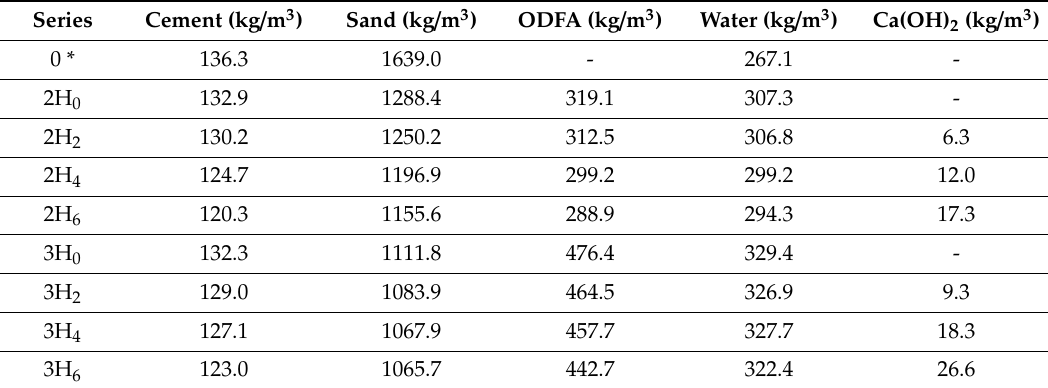
Table 2. The qualitative and quantitative composition of the